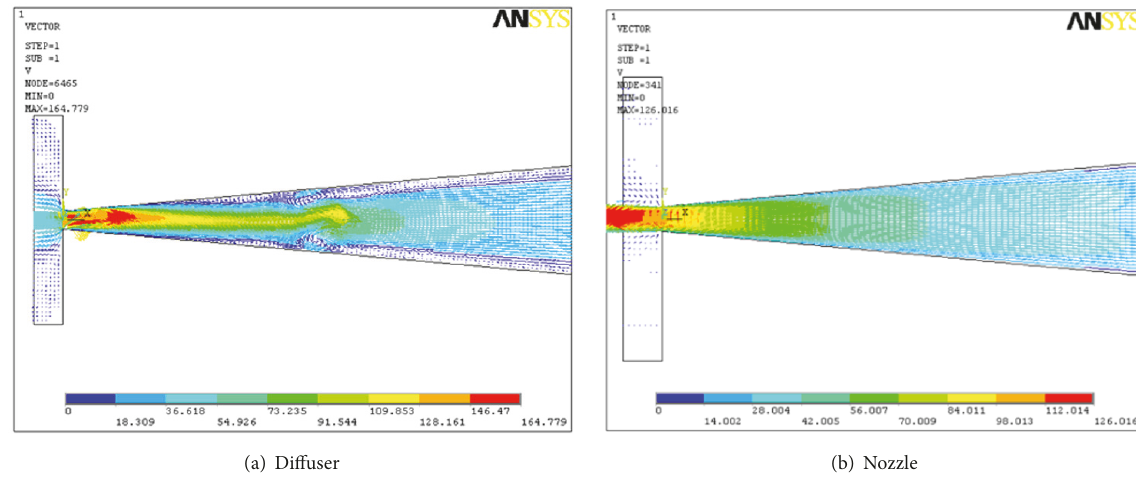
Figure 12: Flow field vector diagram in the conical